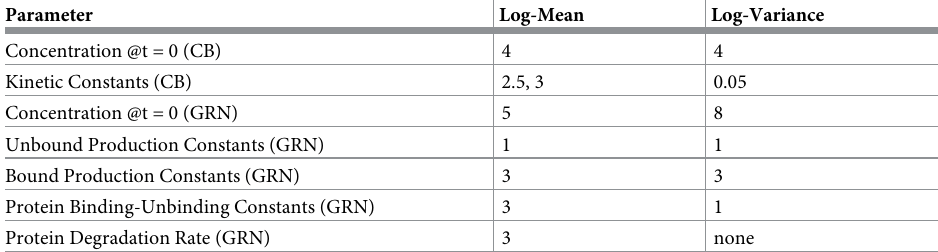
Table 1. Simulation parameter distributions for randomized Complex-Balanced Networks (CB) and Gene Regula- tory Networks (GRN). Parameter